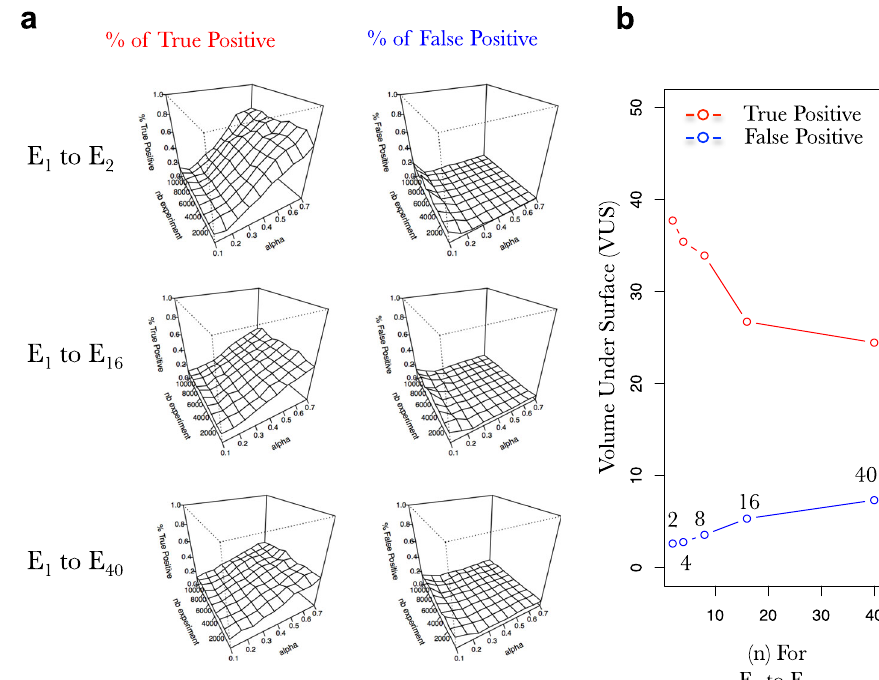
Fig. 7 Early short dynamics in gene expression are more useful to properly learn the network than longer ones. a Surfaces exploring the SVM accuracy (% of true positive on left and % false positive in right ) to predict the connections in a FRANK generated network (100 TF, 1000 TA) using an increasing number of simulated gene expressions ( nb experiment ; y -axis) and an increasing fraction of the network as prior knowledge ( alpha [rows are used as prior knowledge]; x -axis). Percentage of true positive and false positive are evaluated based on predictions of the presence of an edge and its positive or negative in fl uence. b Progression of the volume under the surface (as in a ) computed for a progression in (A + I) n for the % of true positive ( red ) and the % of False positive ( blue ) predicted connections in the network. Simulated gene expression data kind: dynamic (E 1 to E n ); prior knowledge data kind